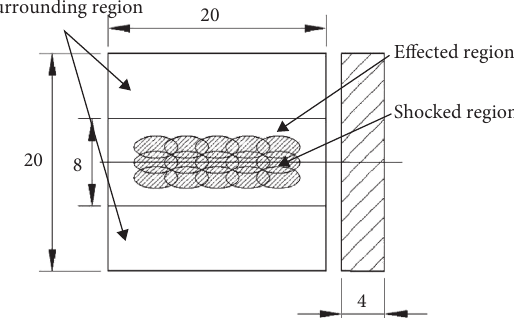
Figure 4: Schematic diagram of model size in FEM.